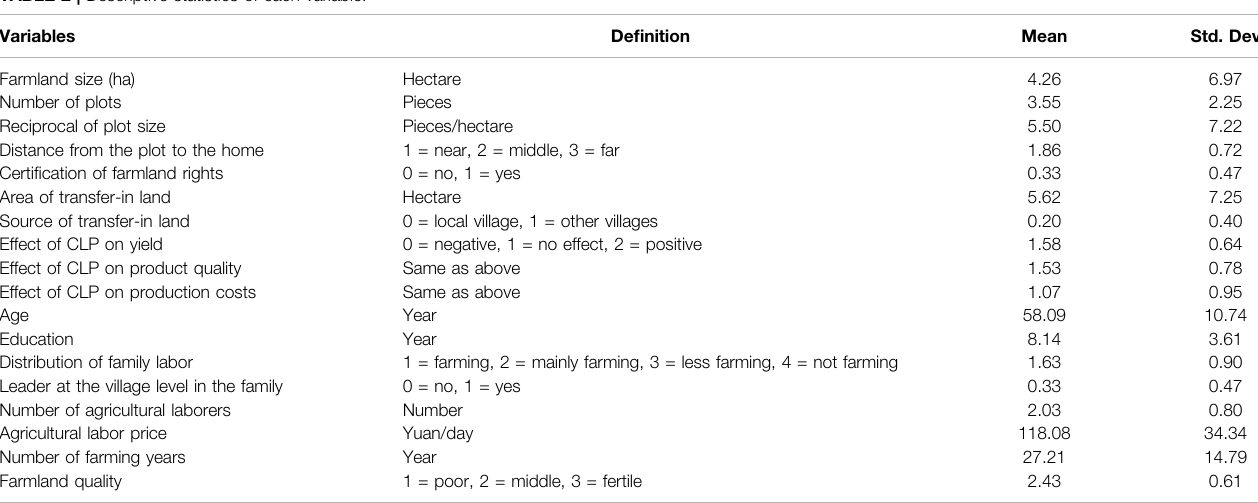
TABLE 2 | Descriptive statistics of each